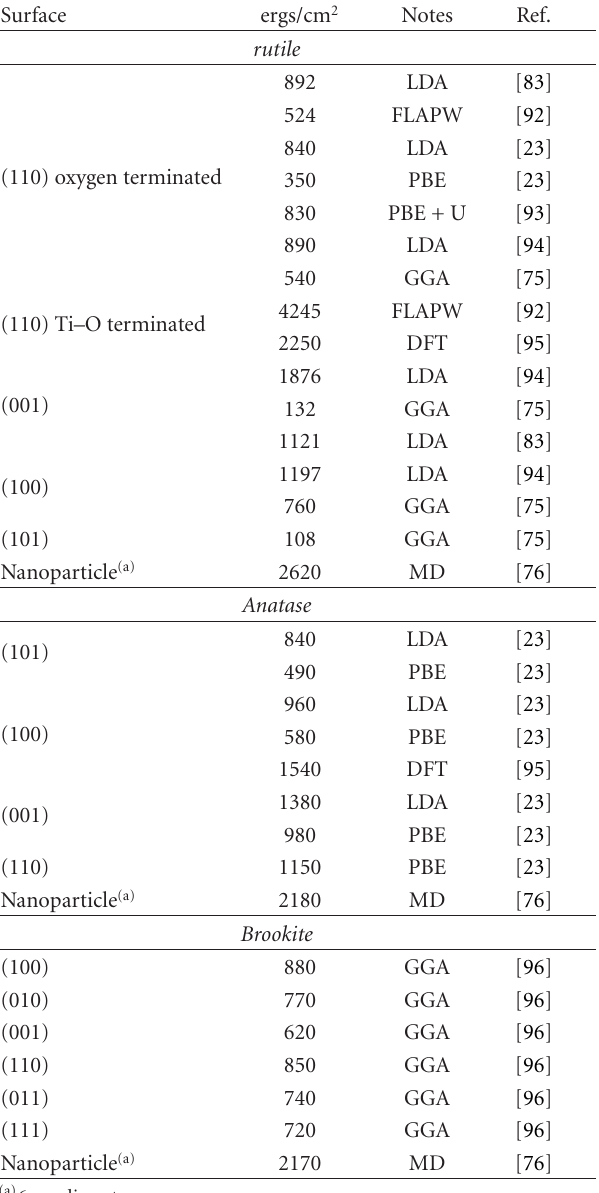
Table 2: Surface energies for TiO 2 . Details of specific surface expo- sure are given in Ref.